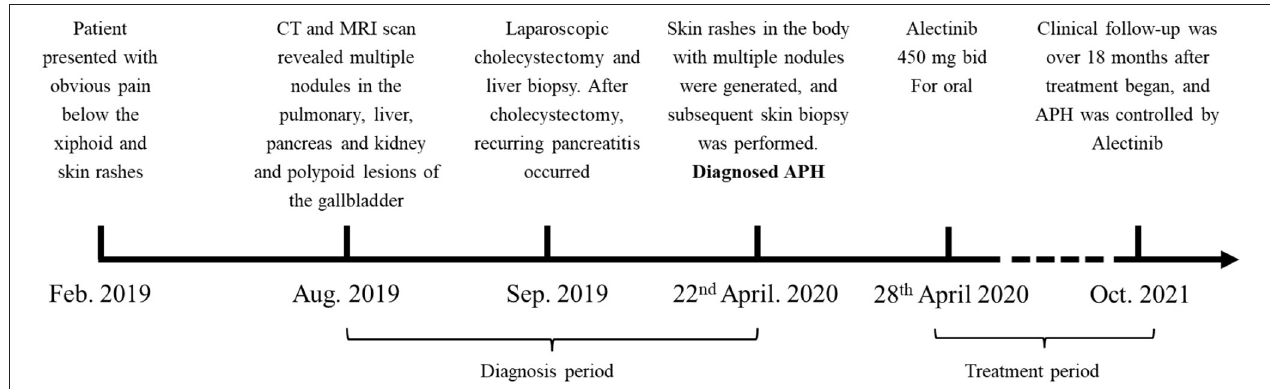
FIGURE 1 | Treatment timeline. The patient suffered from APH since February 2019, and diagnosed in April 2020. After diagnosed, the patient was maintained on alectinib since the 28th April 2020. PR respond